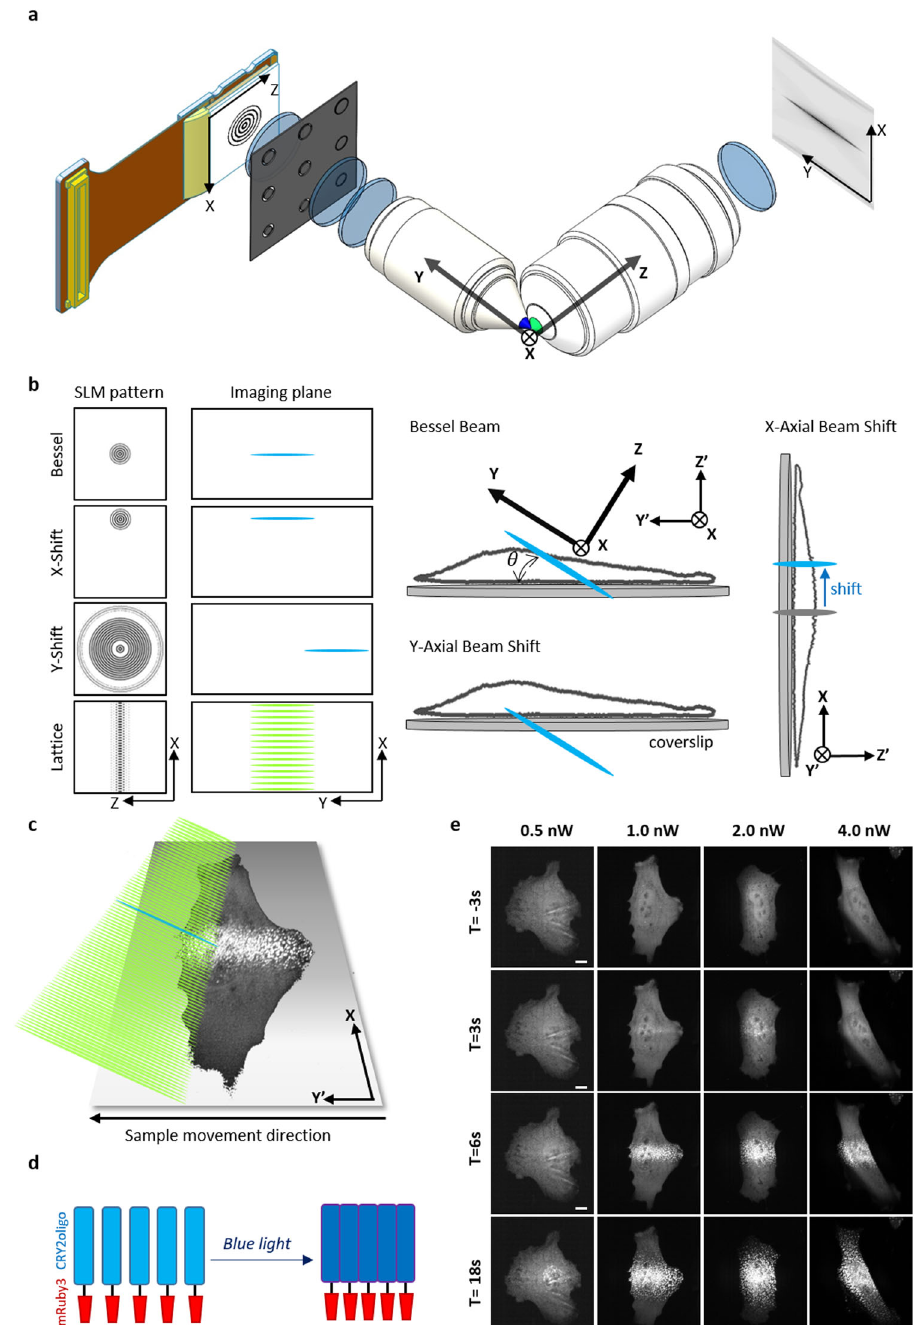
Fig. 1 The scheme for optoLLSM and light-triggered CRY2olig aggregations. a The schematic diagram of the major optical components in lattice lightsheet microscopy (LLSM). The patterns displayed by the spatial light modulator (SLM) are imaged at the pupil plane of the excitation objective through an annual mask and lens. Lattice beams, in addition to Bessel beams with different X, and Y positions, can be generated at the imaging plane by imposing different patterns on the lightsheet microscopy (LSM). b Various patterns on the SLM for generating the corresponding excitation beams in the imaging plane. The position of the Bessel beams can be shifted in the X or Y direction by using X- or Y-shift patterns. For normal Bessel beam stimulation, the Bessel beam with a length of 20 μ m illuminates the cell at a tiled angle of 32.8 degrees. With Y-shift stimulation, the Bessel beam can be moved along the propagation direction to illuminate the basal membrane. With an X-shift pattern, the Bessel beam can be moved to a different location in the x-direction with an accuracy that is better than 100 nm. c The illumination scheme for an optogenetic experiment. The blue beam represents the Bessel beam at 488 nm used to activate the optogenetic molecules, and the green lightsheet represents the 561 nm lattice lightsheet for imaging. The volumetric image was obtained by dithering the lattice beam and moving the sample along the Y ’ direction. d The schematic for optical induced clustering of cryptochrome 2 (CRY2)olig-mRuby3. Blue: CRY2olig, Red: mRuby3. e The time-lapse maximum intensity projection (MIP) images of CRY2olig-mRuby3 expressed cells with various activation energies. The interval between each stack is 3 s. Scale bar 10 μ m.